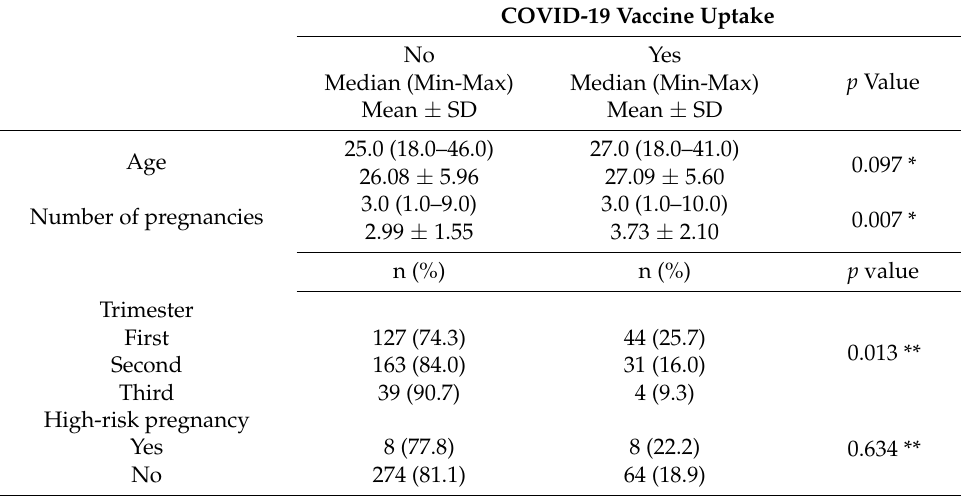
Table 4. COVID-19 vaccine uptake of pregnant